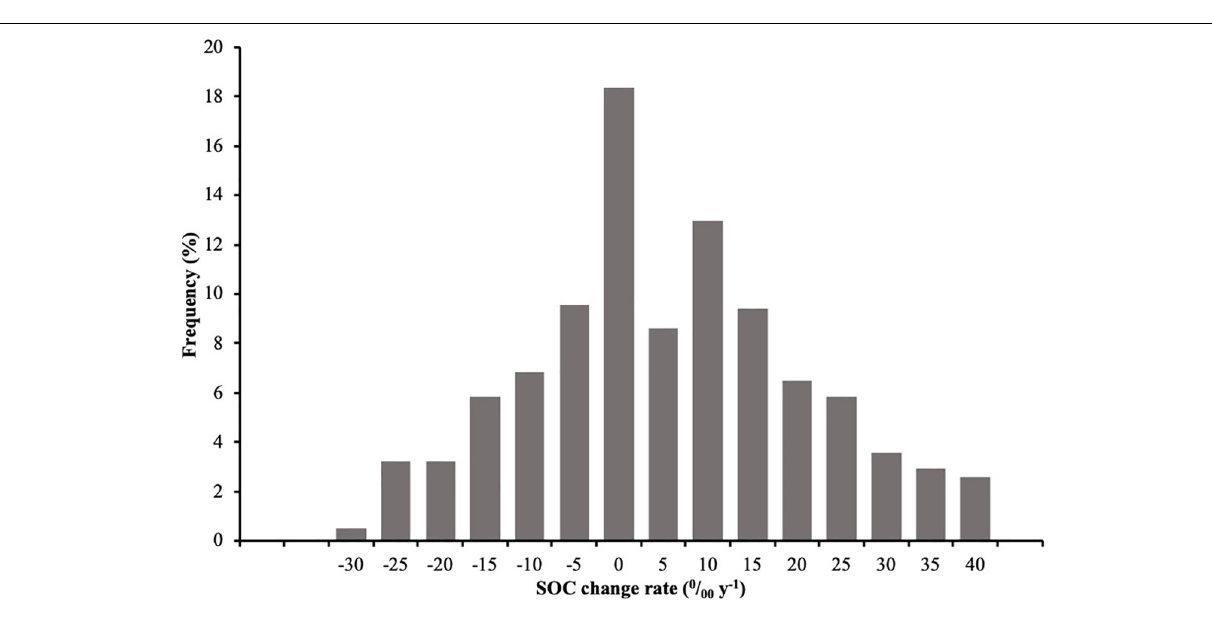
FIGURE 4 | Histogram of the observed annual soil organic carbon (SOC) change rate for 390 fields of arable land from canton of Geneva. Time lag between two SOC analyses 10 years and sampling performed by